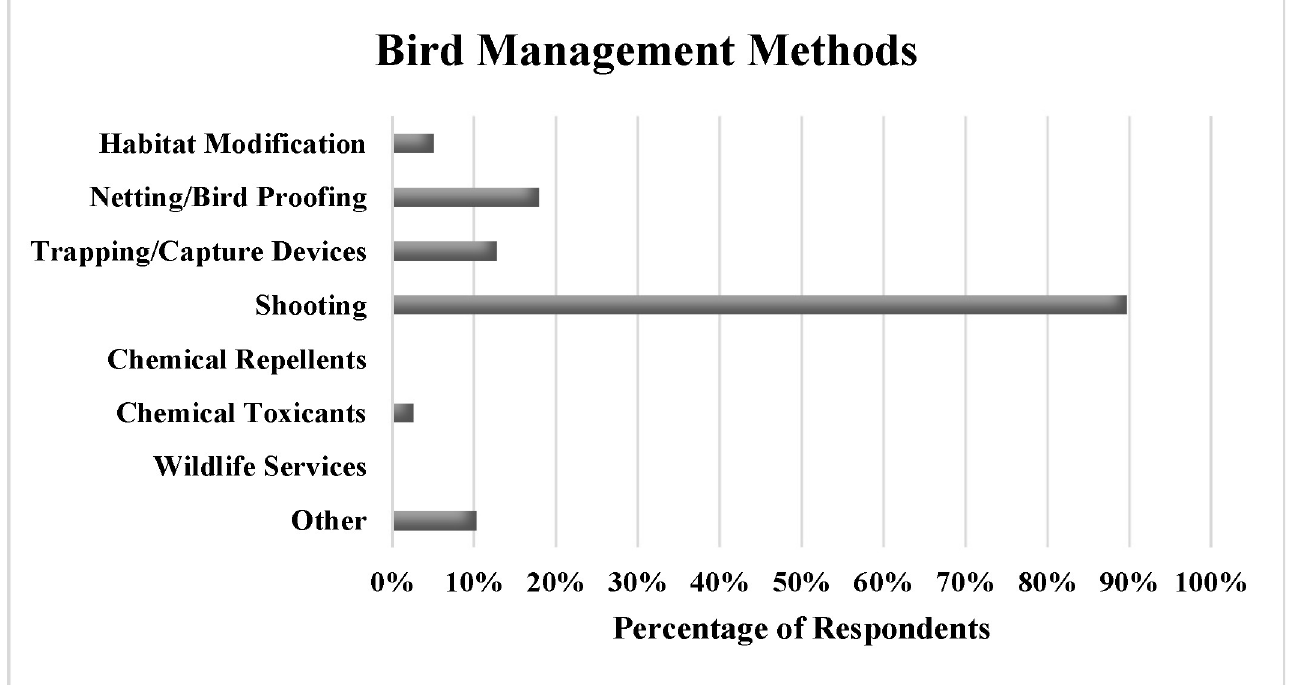
Fig 6. Percentage of respondents using each bird management